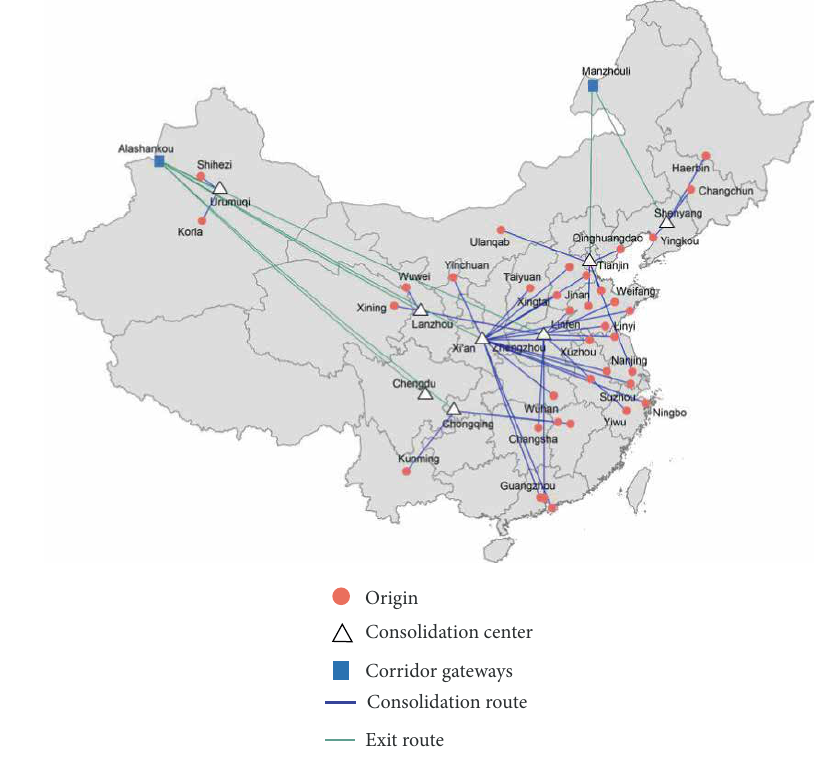
Figure 8: The optimal CRECN in 2017.